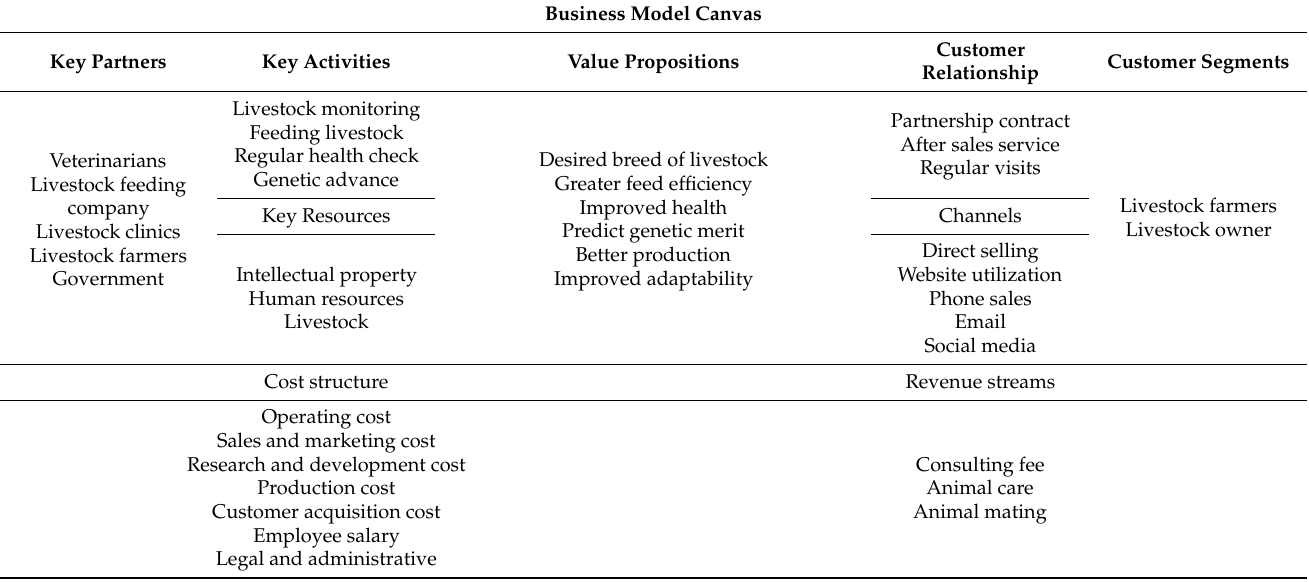
Table 2. Overview of market research analysis for multimodal sensor platform for the dairy sector.